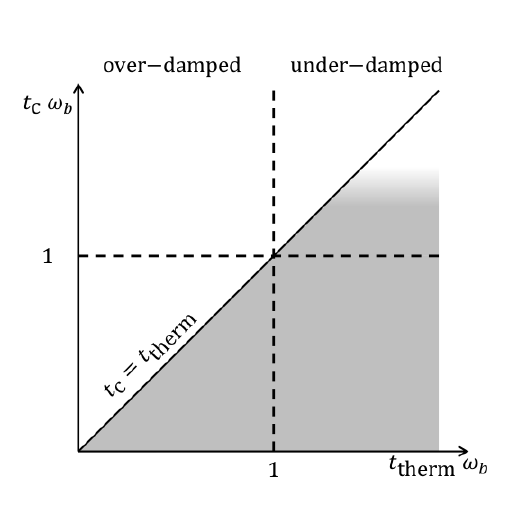
ω ω – t c b b therma is the inverse rate of inter- c